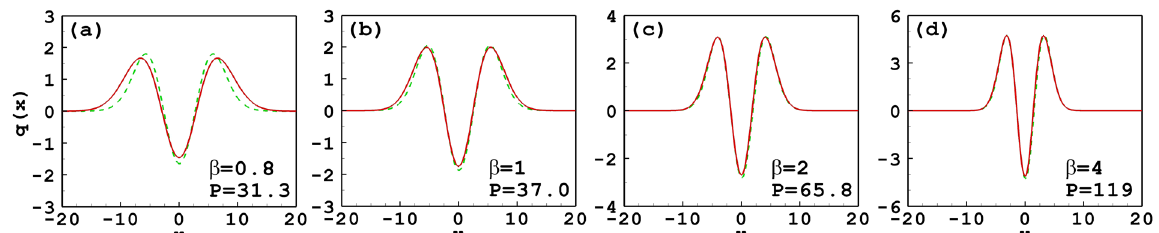
Figure 7. Profiles of the tripole-mode soliton with different soliton powers and propagation constants by expanding the response function to the fourth order. The solid line and the dashed line denote, respectively, the approximate solutions and the numerical ones. Parameter w m = 10 for all cases.